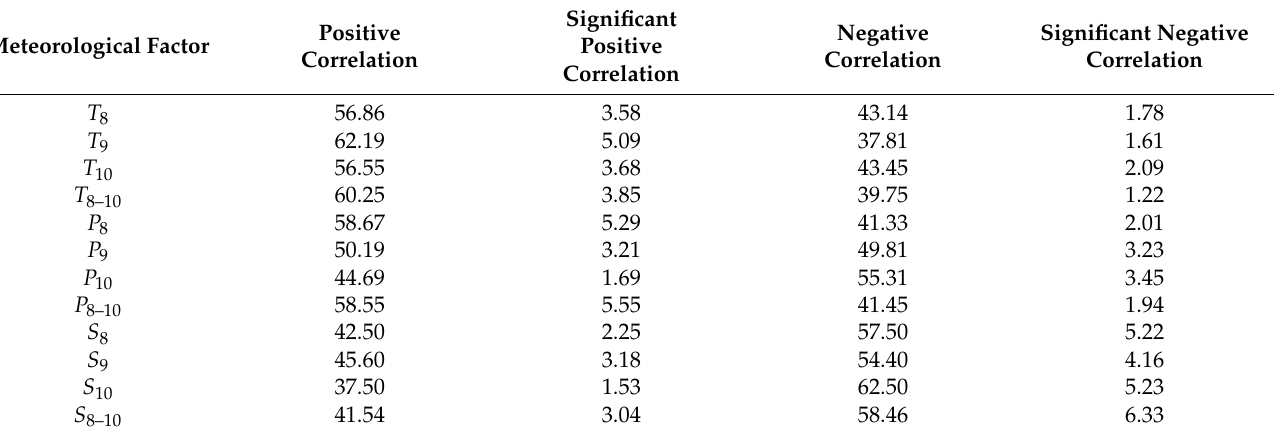
Figure 19. Spatial distribution of the sensitivity coefficients between the EOS of the vegetation and sunshine duration in August ( a ), September ( b ), October ( c ) and August–October ( d ) in the Three-River headwaters region. Table 4. Statistics on the correlation between the EOS of the vegetation and meteorological factors in different time periods in the Three-River headwaters region (%).